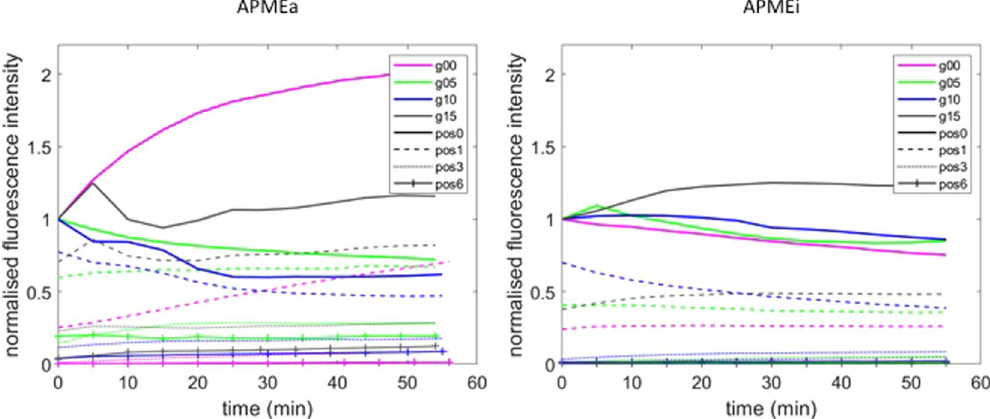
Figure 5. Evolution of fluorescence intensity as a function of time. The fluorescent intensities were extracted from images acquired during 55 min on positions 0 (Pos0), position 1 (Pos1), position 3 (Pos3) and position 6 (Pos6) for the native (APMEa) and the heat-inactivated (APMEi) enzyme. The intensity values were normalized on the values at Pos0 and T0 for each kinetic experiment. The gels were prepared by mixing 1.5% LM pectin with no cellulose (g00, pink), 0.5% cellulose (g05, green), 1.0% cellulose (g10, blue), 1.5% cellulose (g15, black).